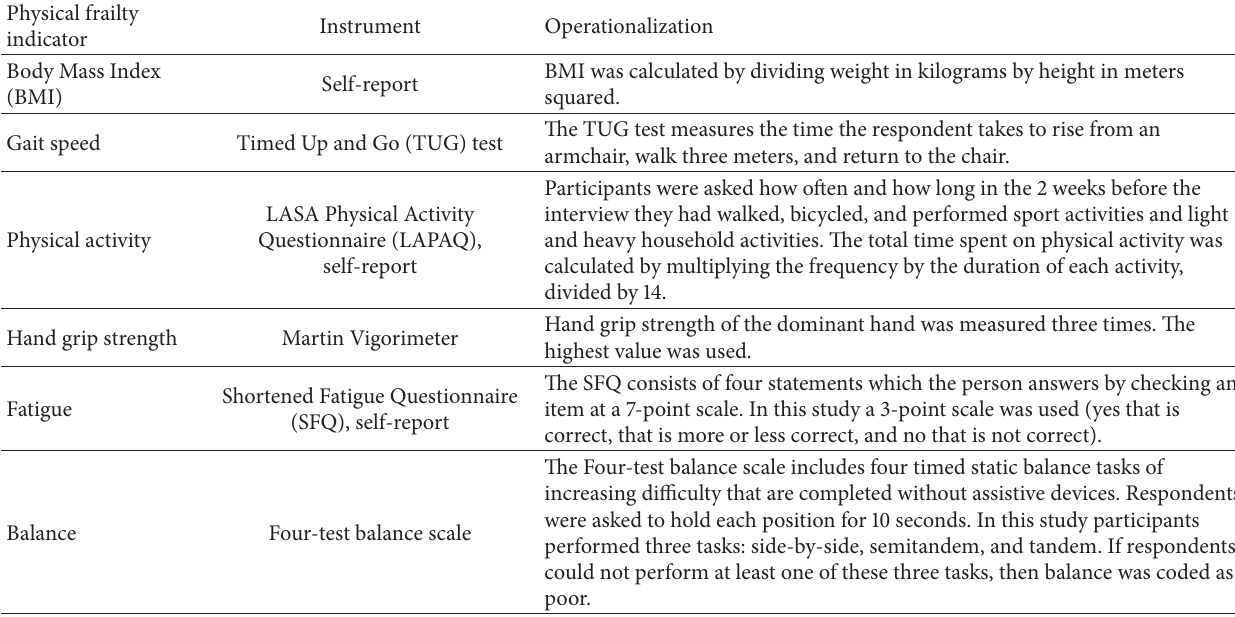
Table 1: Measures used to operationalize the physical frailty